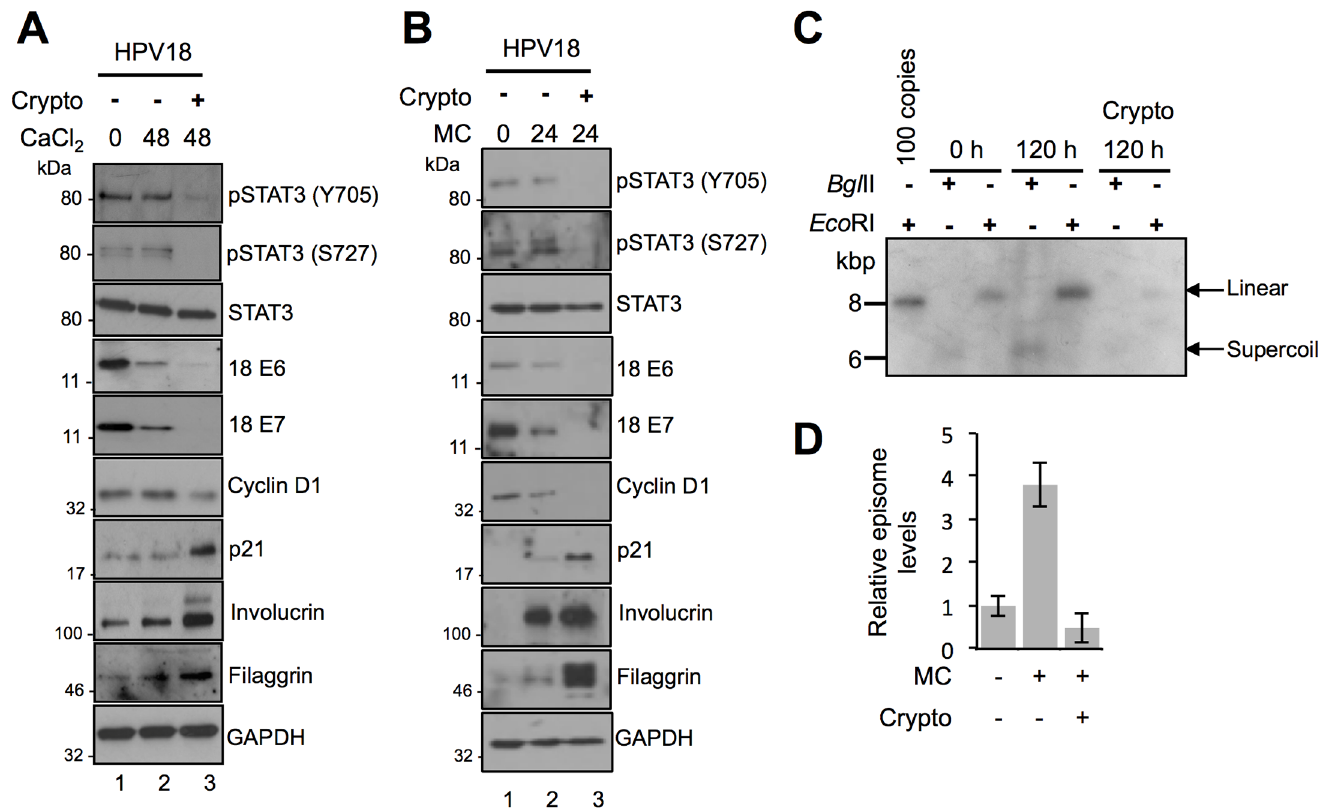
Fig 8. STAT3 is important for cell cycle progression and HPV18 genome amplification in differentiated keratinocytes. Representative western blots of phosphorylated and total STAT3, HPV18 E6 and E7, cyclin D1, p21, involucrin and filaggrin in A) calcium or B) methylcellulose-differentiated HPV18 containing keratinocytes in the presence or absence of 10 μ M cryptotanshione. Data shown represent at least three biological repeats. C) Southern blot analysis of HPV18 episomes in keratinocytes treated with 10 μ M cryptotanshinone and differentiated in methylcellulose for 120 hours. DNA was linearized with Eco RI, producing a single band running at approximately 8 kbp, demonstrating a differentiation-dependent increase in viral episome copy number in untreated control cells and a reduction in episome copy number in cells treated with cryptotanshinone. Digestion with Bgl IIshows a lack of detectable multimeric/integrated HPV genomes in all experimental conditions. Data shown are representative of two donor cell lines. D) Signal intensity was quantified using ImageJ software. Bars represent means ± standard deviation of two biological repeats from two donor cell lines.